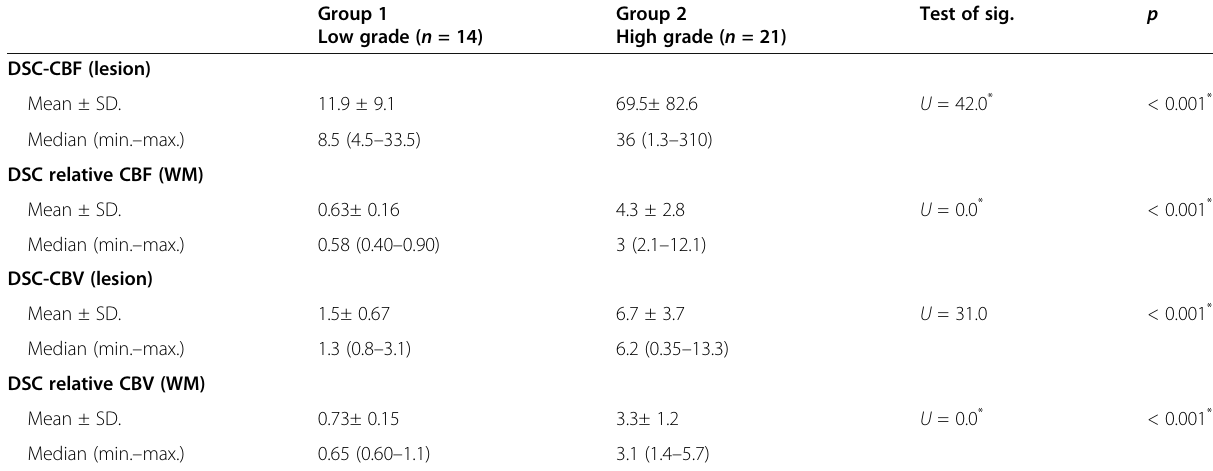
Table 2 DSC-PI findings in the studied groups